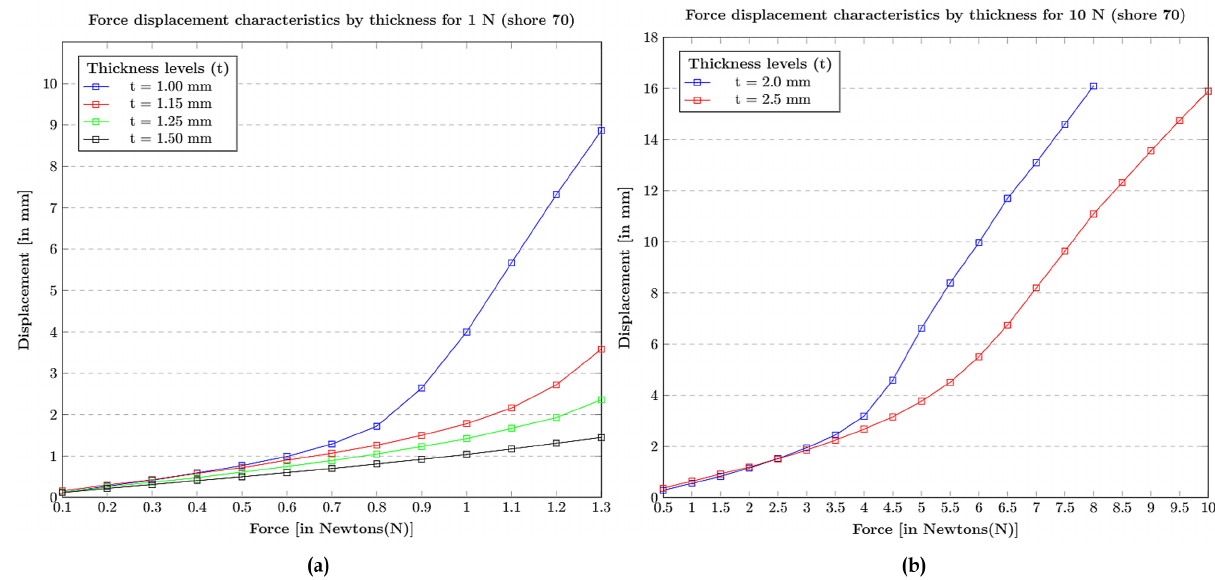
Figure 6. Choosing the thickness of the tactile fingertip: ( a ) Force displacement characteristics by thickness at 1 N for shore 70. ( b ) Force displacement characteristics by thickness at 10 N for shore